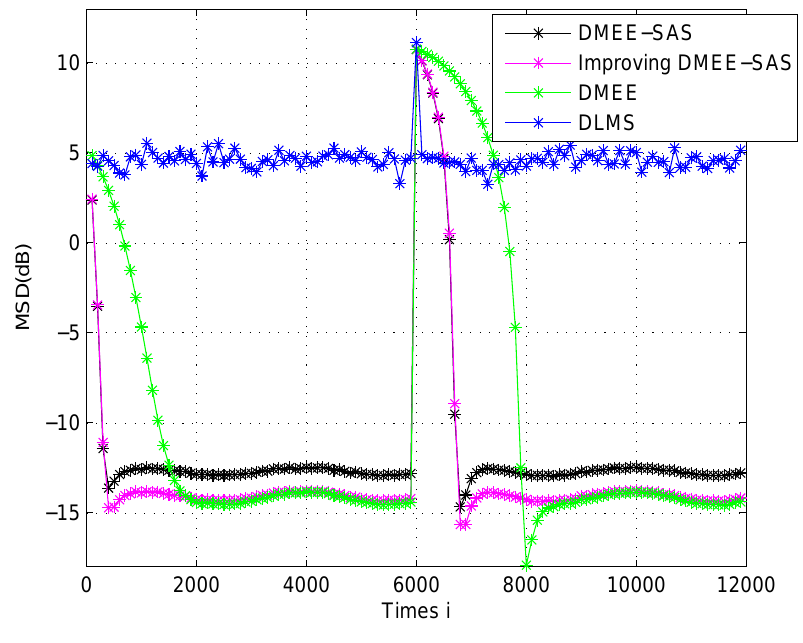
Figure 3. MSD learning curves in a non-stationary